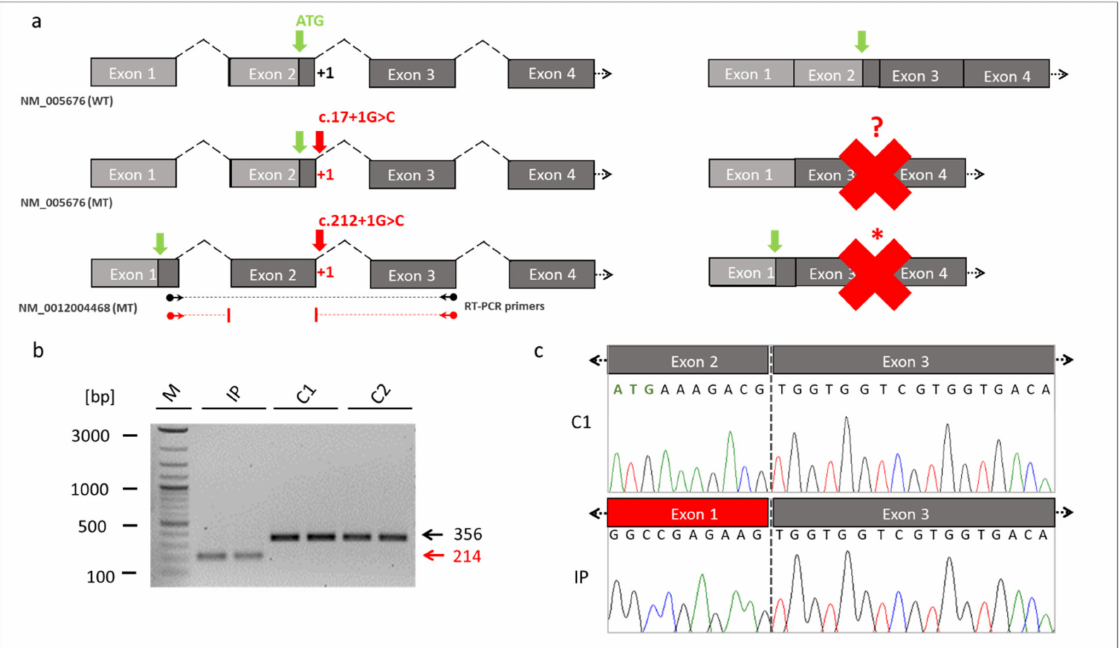
Figure 3. Skipping of the exon 2 in RBM10 . ( a ) Schematic drawings of the exons of RBM10 based on the reference transcript variant 1 (NM_005676) and transcript variant 5 (NM_0012004468). The location of the novel splice variant at the junction site between exon 2 and intron 2 is shown in red. The identified splice variant at position +1 of the donor splice site (red arrow) resulted in exon 2 skipping and loss of the start codon (green arrow) in the RBM10 transcript variant 1. It unclear whether an alternative start codon was generated (red question mark). The same splice variant caused a frameshift and abnormal stop codon (red asterisk) in the RBM10 transcript variant 5. The dark grey boxes referred to the coding exons, while the light box referred to the noncoding exons. Binding sites of the RT-PCR primers are shown by the black (WT) and red (MT) arrows ending in spheres (transcript NM_0012004468). ( b ) RT-PCR from patient-derived fibroblast cell lines. The RT-PCR showed a reduced fragment size in the TARP-affected patient (reduced by 142bp, NM_0012004468: c.212+1G>C, p.Glu24Valfs127*). The reduced intensity of the IP ´ s fragment indicated that